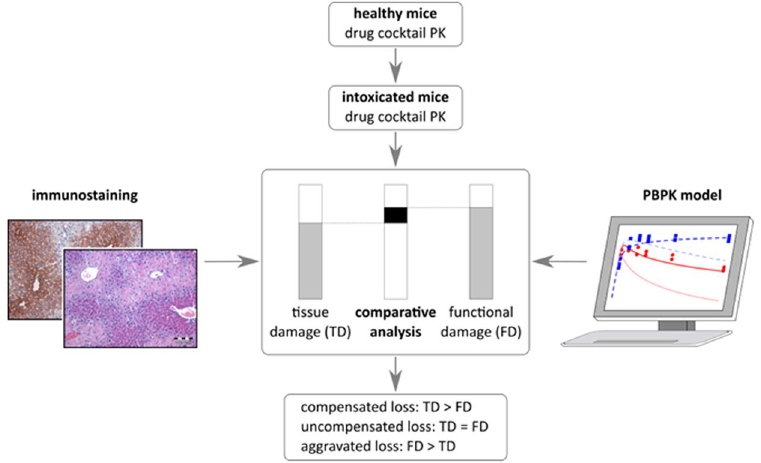
Figure 1. Overall workflow. In a first step, models for healthy mice were established on the basis of literature knowledge and own experimental data including PK measurements and quantification of enzyme expressing area of the liver lobule. The models were further adjusted to the plasma concentration profiles of intoxicated mice by reducing the clearance capacity of the liver (functional damage, FD). In a complementary approach, the dead cell area of the liver lobule was measured to quantify the tissue damage (TD). The functional damage was then compared to the tissue damage to differentiate between compensated, uncompensated and aggravated loss, respectively, of metabolically active